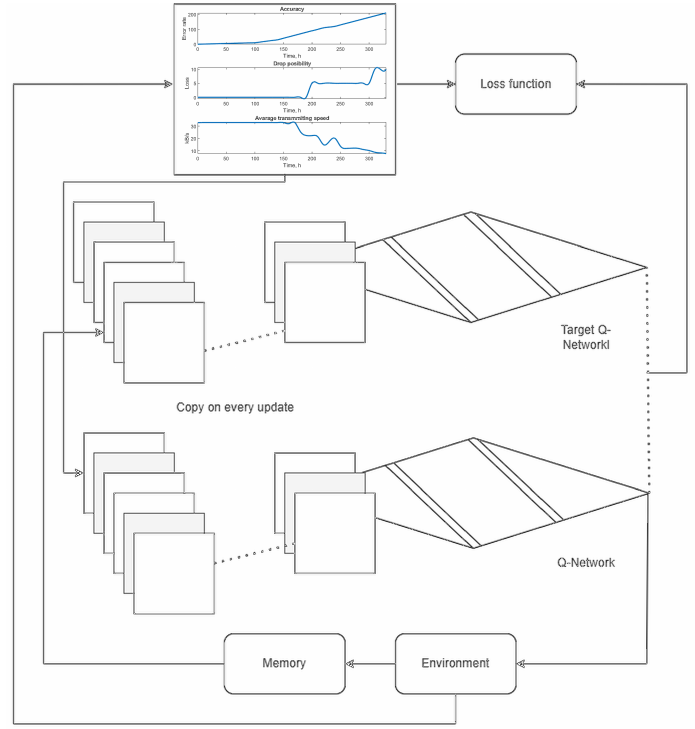
Figure 3. The architecture of the proposed PowerQnet